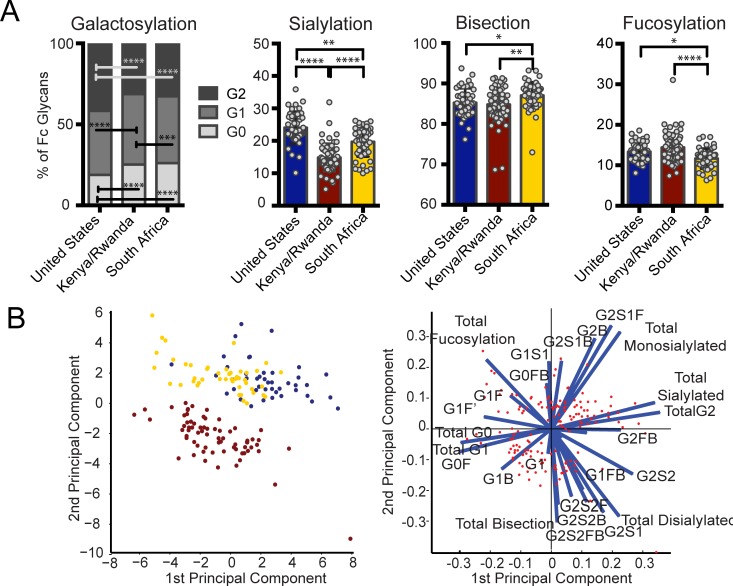
Geographic location affects bulk IgG glycosylation.Bulk IgG glycosylation was assessed in subjects from three regions: Unite States (blue, n = 43), Kenya and Rwanda (maroon, n = 69), and South Africa (yellow, n = 47). (A) Bulk antibody Fc glycosylation in vaccine recipients from each of the three regions was measured via capillary electrophoresis, and the mean proportion of total galactosylated, sialylated, fucosylated, and bisected structures was compared using Kruskal-Wallis one-way ANOVA (*p<0.05, **p<0.01, ***p<0.001, ****p<0.0001). (B) Multivariate comparison of antibody Fc glycosylation among the three geographic sites was performed using PCA. The score plot (left panel) depicts the principal component analysis of samples collected in the three regions (each dot represents a vaccinee, and colors are as described above), and the loadings plot of the PCA (right panel) shows the contribution of particular glycan structures to driving the observed separation, where longer arrows signify a greater contribution to separating glycan profiles. This PCA describes 55% of the total variance among these samples.